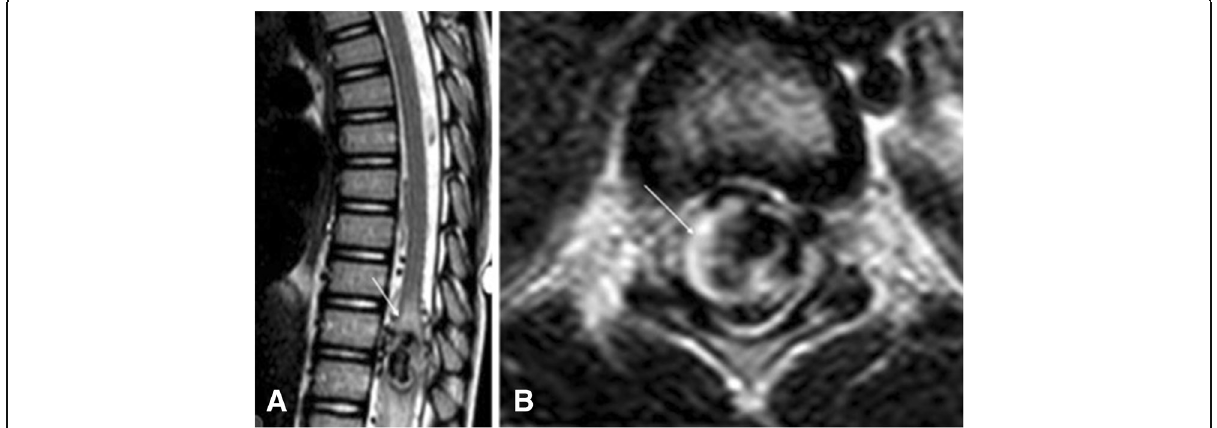
Fig. 1 A and B 3 yo male with left perimedullary fistula. Lateral and axial T2 weighted images of the spinal show similar findings. There is abnormal high T2 signal within the spinal cord (white arrow) surrounding the venous